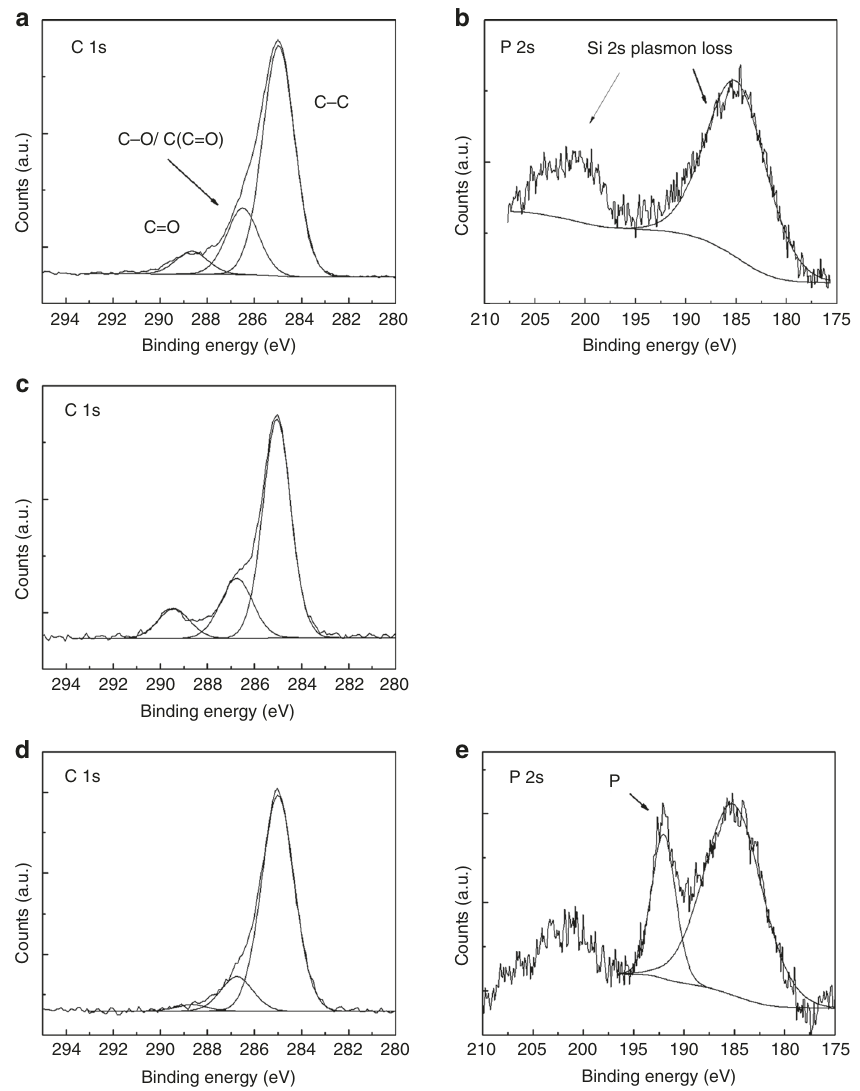
Fig. 2 XPS spectra of modi fi ed silicon samples. a High-resolution narrow scans of C 1s and b P 2s obtained from 5-hexenyl acetate monolayers on silicon (surface 2 in Fig. 1). c C 1s spectrum of hydroxyl-terminated surface 3. d High-resolution scans of C 1s and e P 2s from phosphorus-modi fi ed silicon sample